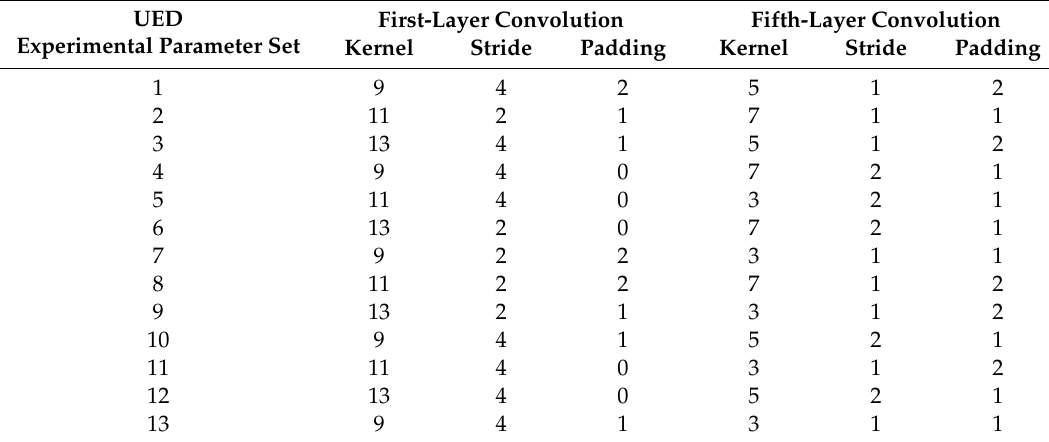
Table 8. The uniform experiment table of the two-input CNN.